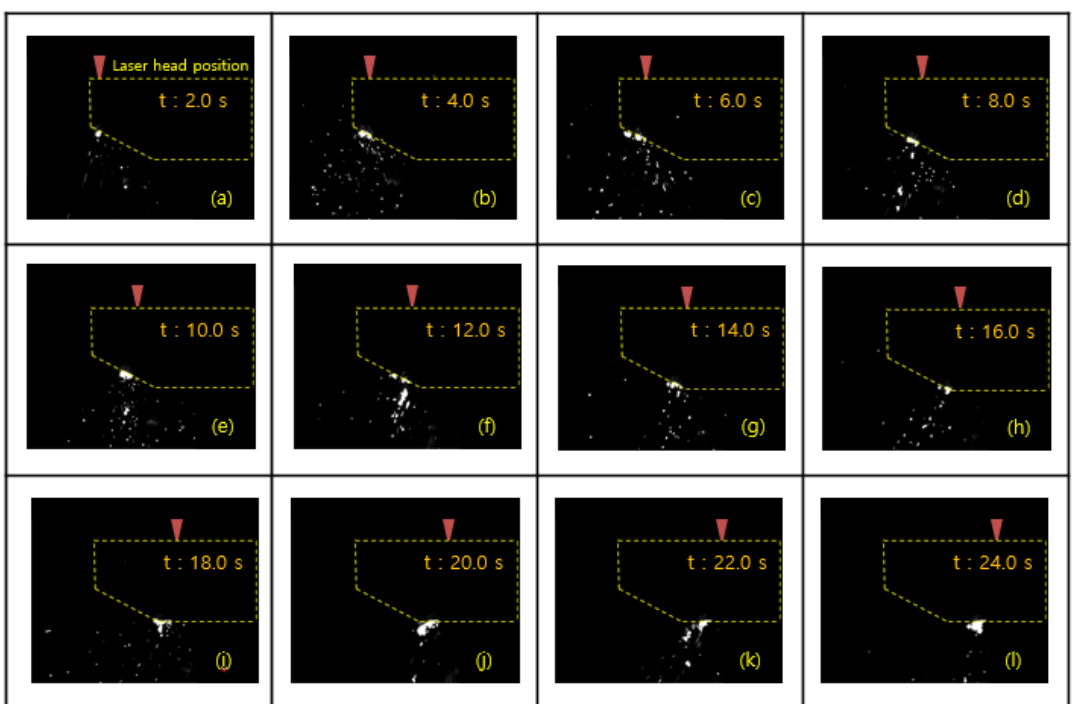
Figure 8. Molten pool behavior and evacuation captured by the high-speed camera in case 4 at ( a ) t: 2.0 s, ( b ) t: 4.0 s, ( c ) t: 6.0 s, ( d ) t: 8.0 s, ( e ) t: 10.0 s, ( f ) t: 12.0 s, ( g ) t: 14.0 s, ( h ) t: 16.0 s, ( i ) t: 18.0 s, ( j ) t: 20.0 s, ( k ) t: 22.0 s, and ( l ) t: 24.0 s. mm ) ace ( f u r s m o tt bo e Figure 9. Location of molten pool evacuation on the bottom surface along the x-direction for a var- iable time. M o l t e n poo l evac u a t i on po s i t i on o n t h